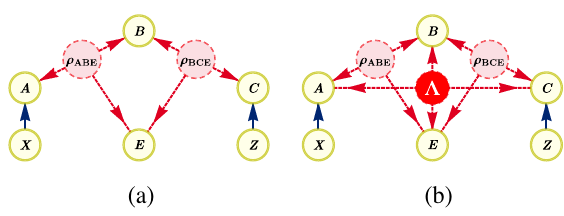
FIG. 14. (a) A and C employ the repeater B in order to generate a secret shared key. While A and C have a choice of which measurement to perform in the states they receive — denoted by X and Z — B performs a four-outcome Bell state measurement. Unbeknown to A , B , and C , a fourth party E may be eaves- dropping the sources in an attempt to extract information about the secret key that A and C are establishing. (b) The eavesdropped network scenario with shared randomness. Some tripartite dis- tributions which are cryptographically secure under the assumption of no shared randomness become insecure if hidden dependence on shared randomness cannot be excluded on physical